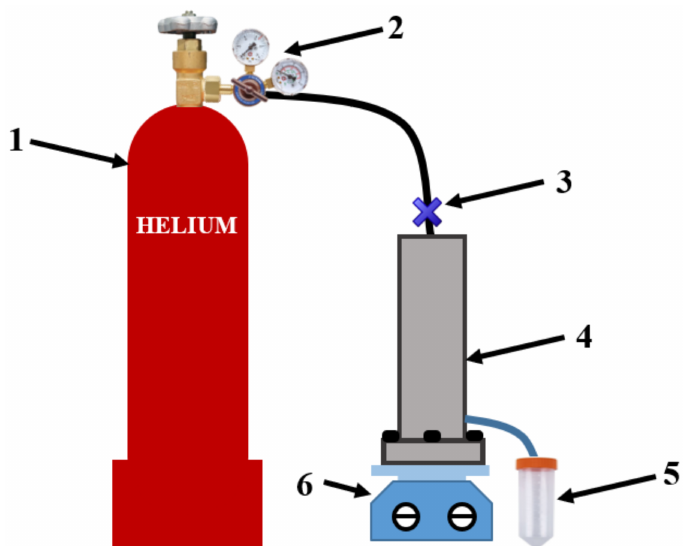
Figure 1. The scheme of the nanofiltration setup: 1—helium cylinder, 2—reducer, 3—gas supply opening/closing valve, 4—nanofiltration cell, 5—test tube with permeate, 6—magnetic